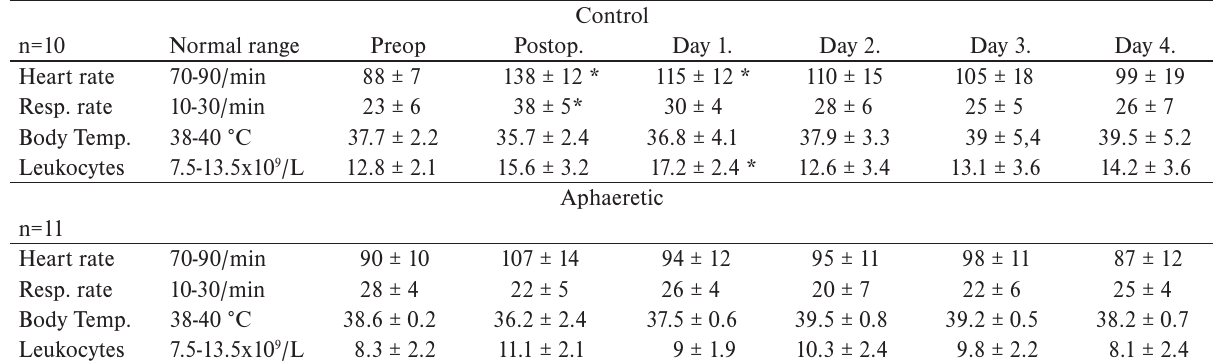
Table 1. physiological data of